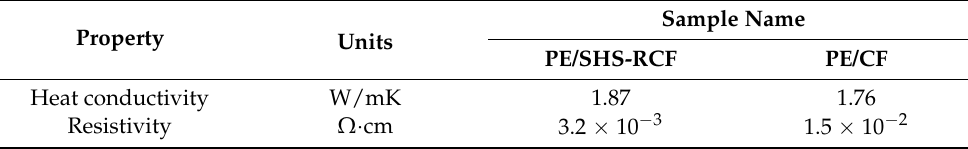
Table 2. Thermal and electrical conductivity of polymer composites with different carbon fiber